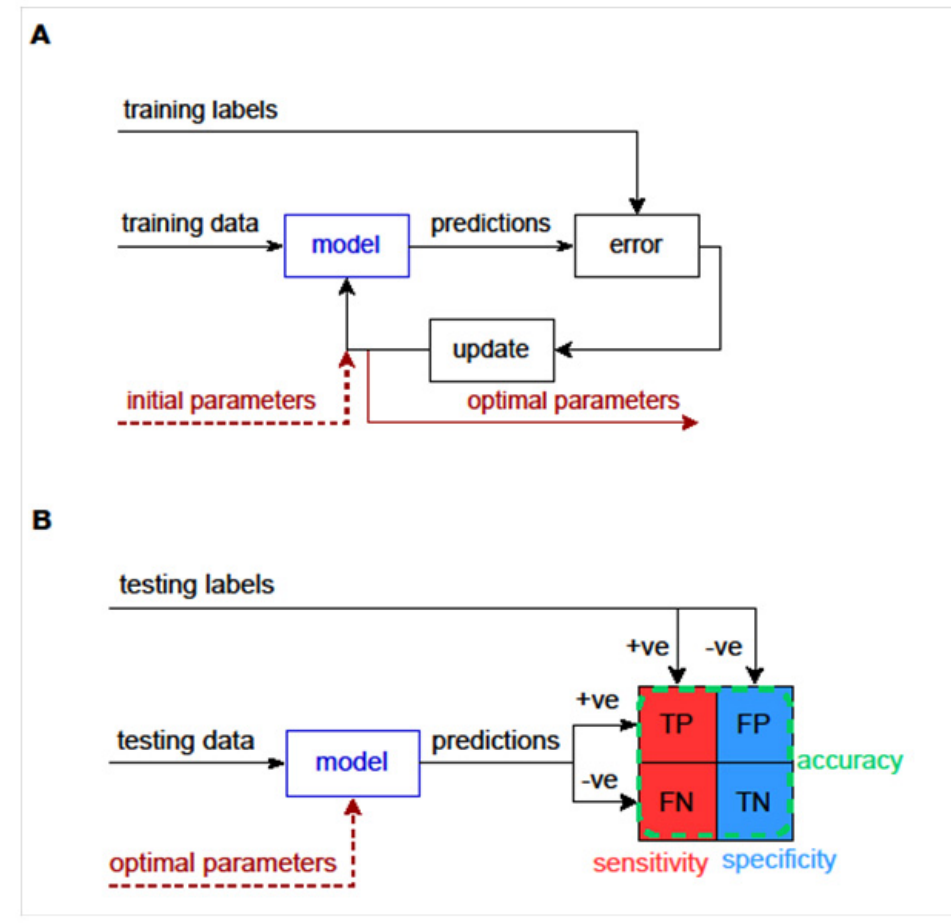
Figure 2. Overview of machine learning approaches. ( A ) Training data and training labels are used to train the model by obtaining its optimal parameters. The model with initial parameters makes predictions for the training data. These predictions are compared to the training labels and the error between them is calculated. The model parameters are updated to correct for the error. These steps continue until the error cannot be made smaller and the model is trained. ( B ) A trained model should be tested with a separate set of data and labels called the testing data. Positive or negative predictions are made for the testing data using the trained model with its optimal parameters. Each prediction is compared to the positive or negative testing label and categorised as a true positive (TP), false positive (FP), true negative (TN) or false negative (FN). The model’s sensitivity can be estimated as TP/(TP+FN), specificity as TN/(TN+FP) and accuracy as (TP + TN)/(TP + FP + TN + FN).